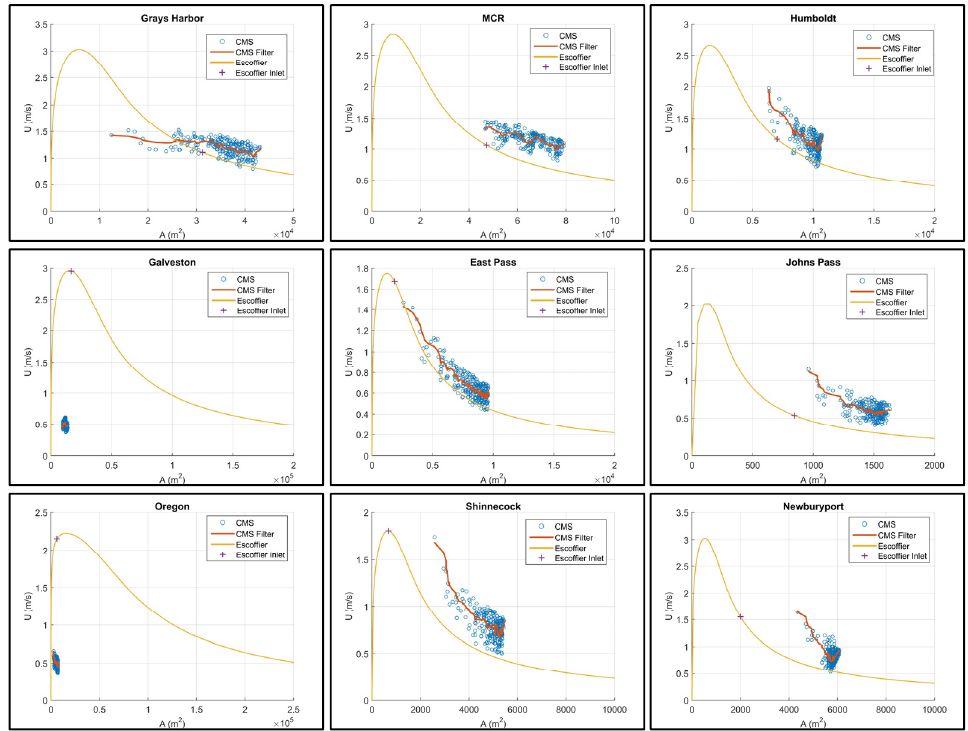
Figure 12. Shoal volume at the end of the simulation derived from the model and the empirical formula of Walton and Adams.